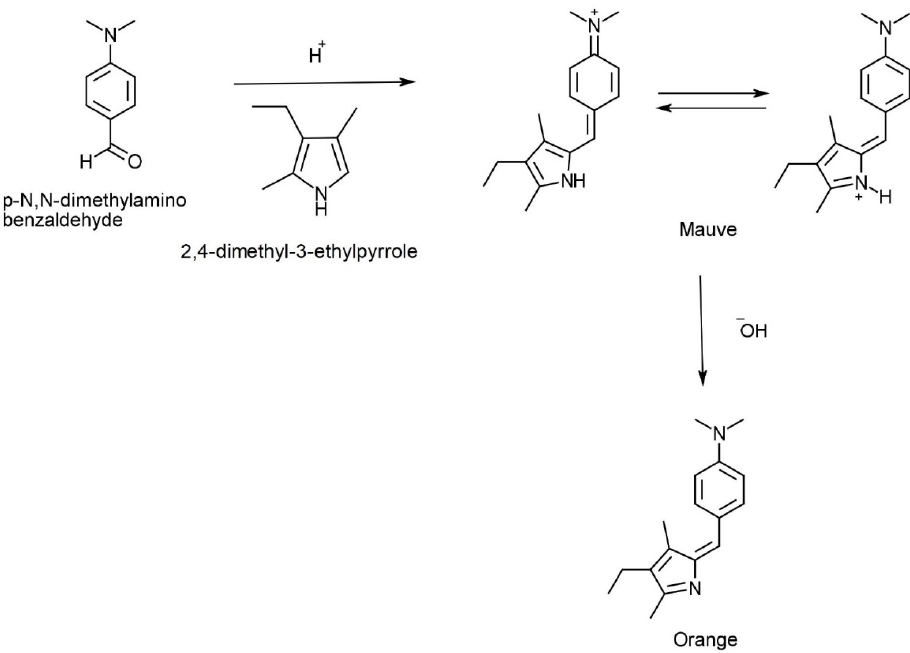
Figure 1. The reaction of p - N , N -dimethylamino benzaldehyde with a model pyrrole (this sequence has been confirmed by NMR in our laboratories).